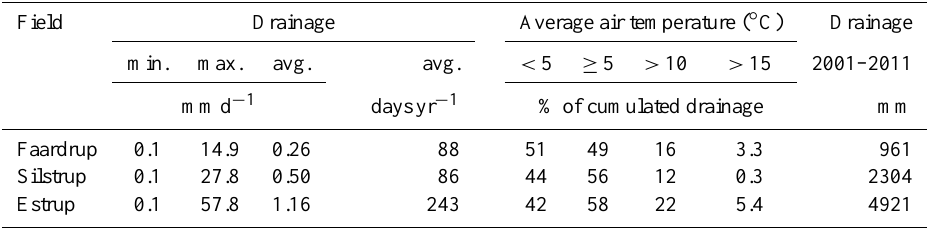
Table 5. Minimum (min.), maximum (max.) and average (avg.) daily drainage, average annual number of days with drainage, average air temperatures during drainage, and cumulated drainage, all 2001–2012 at Faardrup, Silstrup and